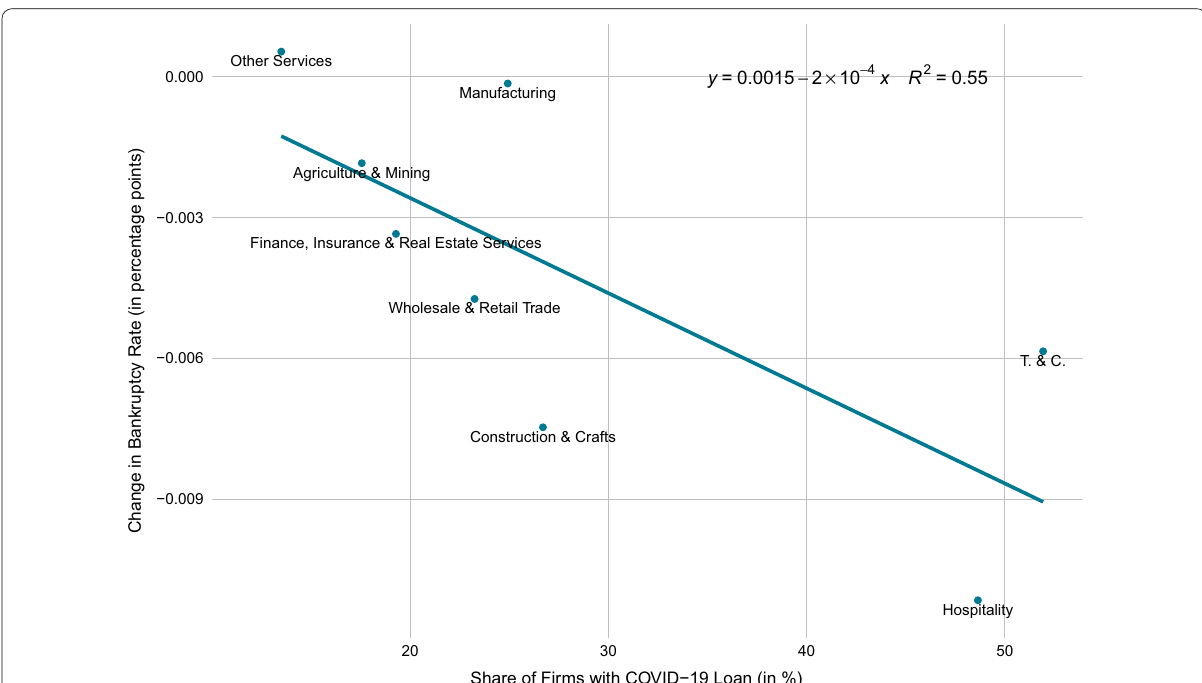
Fig. 7 Relationship of COVID-19 loans and bankruptcies across sectors. Notes : The scatter plot shows the correlation between the share of firms who took out COVID-19 loans and the change in bankruptcy rates across sectors. The change in bankruptcy rates is given by the difference in average bankruptcy rates 22 months before and after the start of the COVID-19 crisis. The results are robust to choosing a 12-month or 18-month comparison window. T. & C. means transport and communication. Hospitality includes hotels, restaurants, leisure and